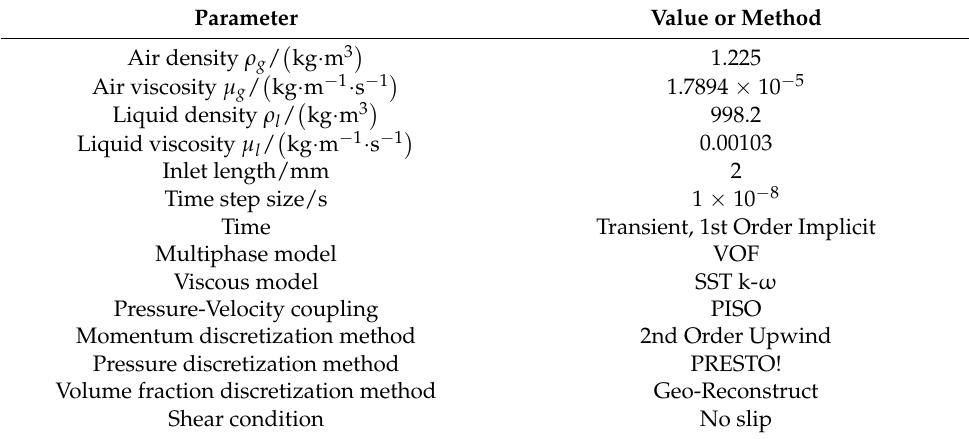
Table 2. Summary of physical parameters and model settings for numerical simulation on nozzle of Respimat ®